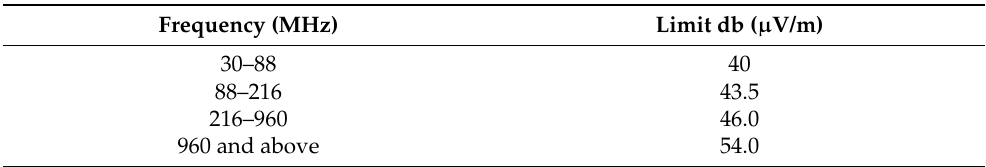
Figure 3. Configuration of EMI suppressor. Table 1. FCC PART 15B regulation